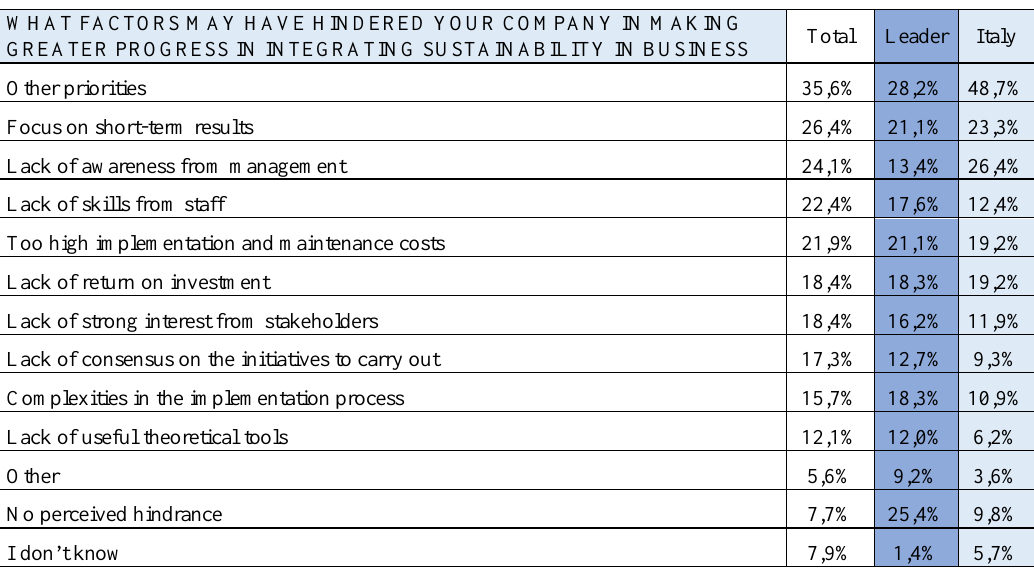
WHAT FACTORS MAY HAVE HINDERED YOUR COMPANY IN MAKING GREATER PROGRESS IN INTEGRATING SUSTAINABILITY IN